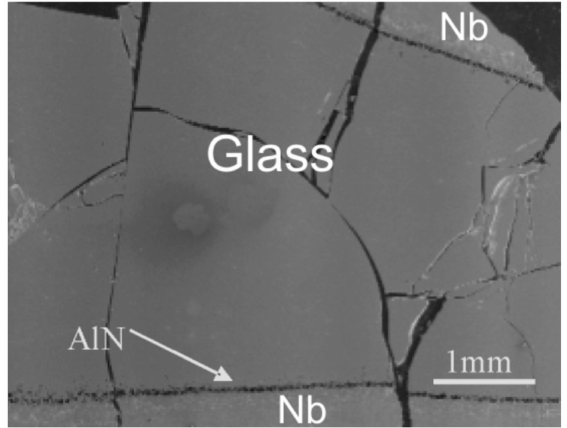
Figure 1. SEM image La − Al − Si − O − N glass prepared in the Nb crucible and AlN as a starting powder, the arrow indicating the wall of the Nb crucible